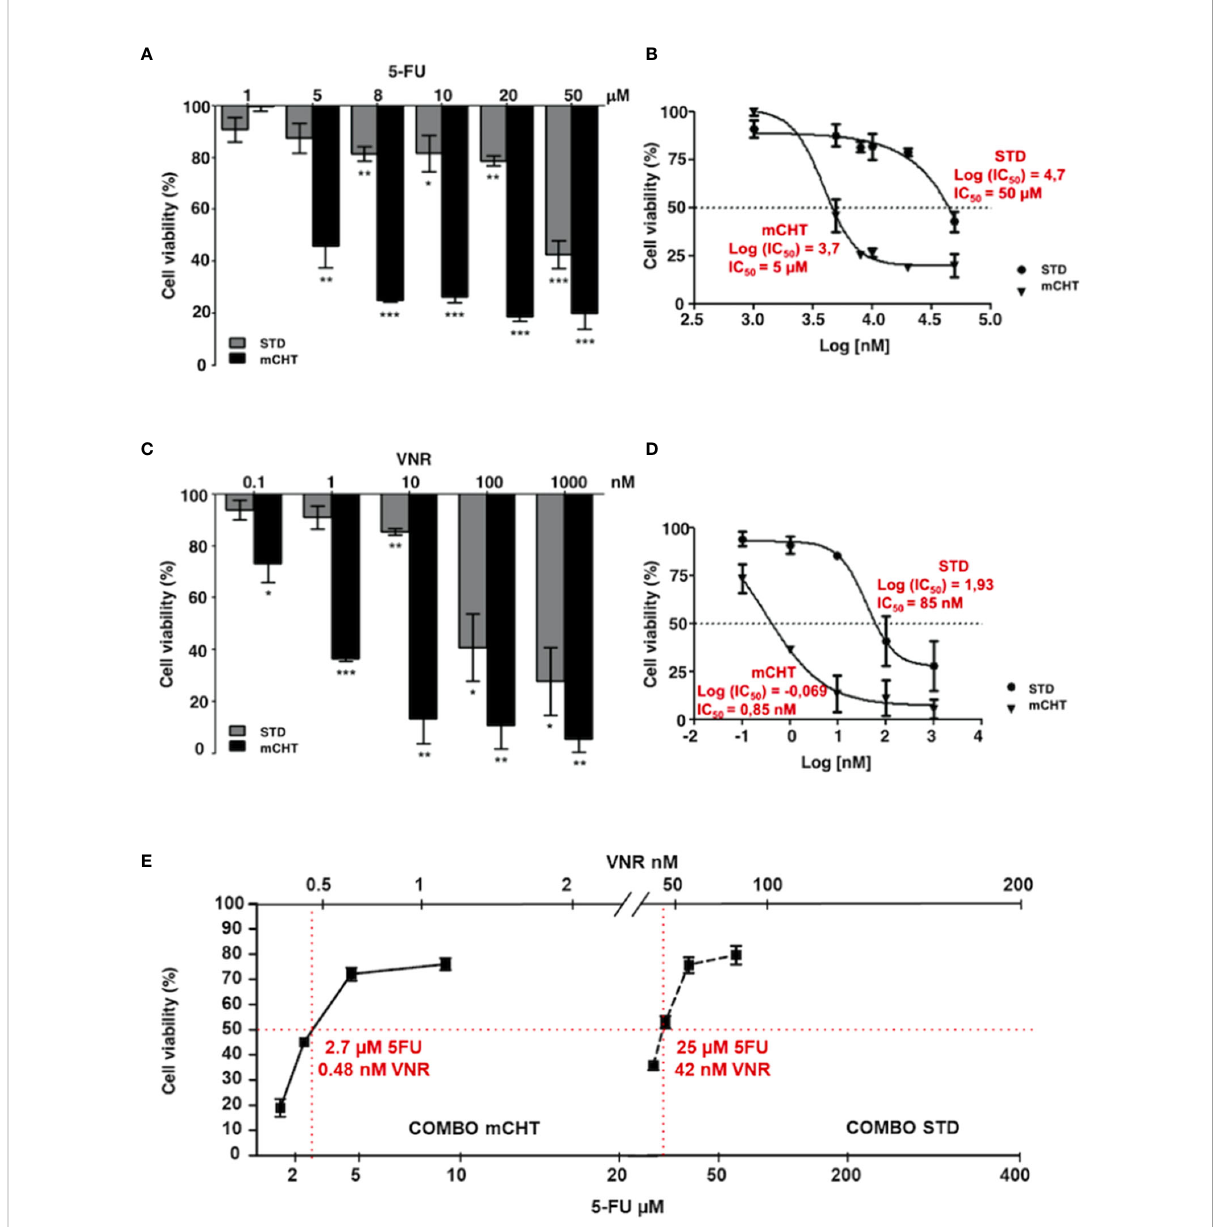
FIGURE 1 Metronomic administration of 5-FU and VNR - alone or in combination - more effectively reduces HUVECs viability, even when used at much lower concentrations than those used for standard treatment. MTT assay performed on HUVECs at the end of STD or mCHT treatment with increasing doses of 5-FU (A) or VNR (C) . Dose-response curves were used to calculate the IC 50 values of 5-FU (B) or VNR (D) treatments. Values represent the average ± SD of three independent experiments and are expressed as the percentage of viability of treated vs. untreated cells *p < 0.05; **p < 0.01; ***p < 0.001. (E) Dose-response curve obtained from MTT assay performed at the end of STD or mCHT treatment with the following concentrations: ¼ IC 50(5-FU) + ¼ IC 50(VNR) ; ½ IC 50(5-FU) + ½ IC 50(VNR) ; IC 50(5-FU) + IC 50(VNR) ; 2x IC 50(5-FU) + 2x IC 50(VNR) . Increasing doses of 5-FU are reported on the lower x-axis and increasing doses of VNR are reported on the upper x-axis. The simple two-point method was used to estimate the IC 50s (reported in red) from 2 data points that reduces cell number to 50% of the control (red lines). Values represent the average ± SD of three independent experiments and are expressed as the percentage of viability of treated vs. untreated